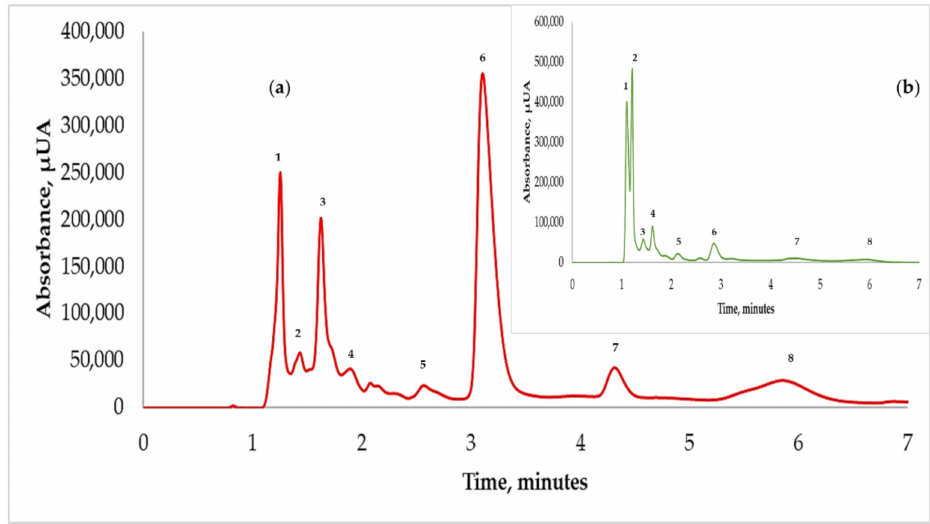
Figure 5. RP-HPLC-DAD ( λ = 210 nm) chromatograms for the organic acids in the optimized sourdough ( a ) and unfermented optimized sample ( b ), according to the elution pattern and chromatographic conditions described in Section 2.4. The injection volume (IV) was 20 µ L and the concentration of the sample was 400 mg/mL. Peak’s identification: 3—lactic acid; 5—acetic acid; 6—propionic acid.